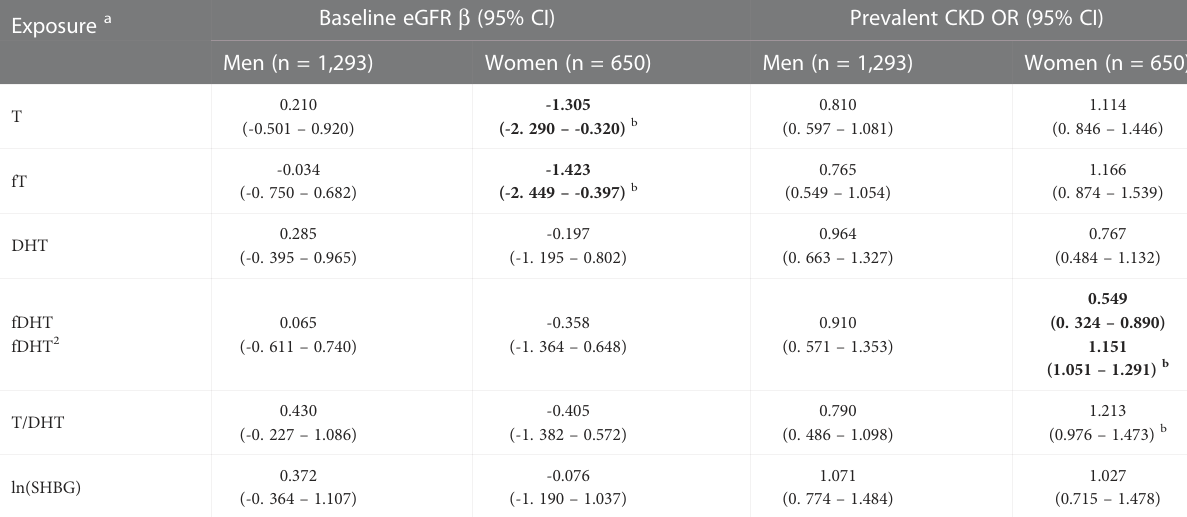
TABLE 2 Cross-sectional associations of endogenous androgens and SHBG with baseline eGFR and prevalent CKD. Exposure